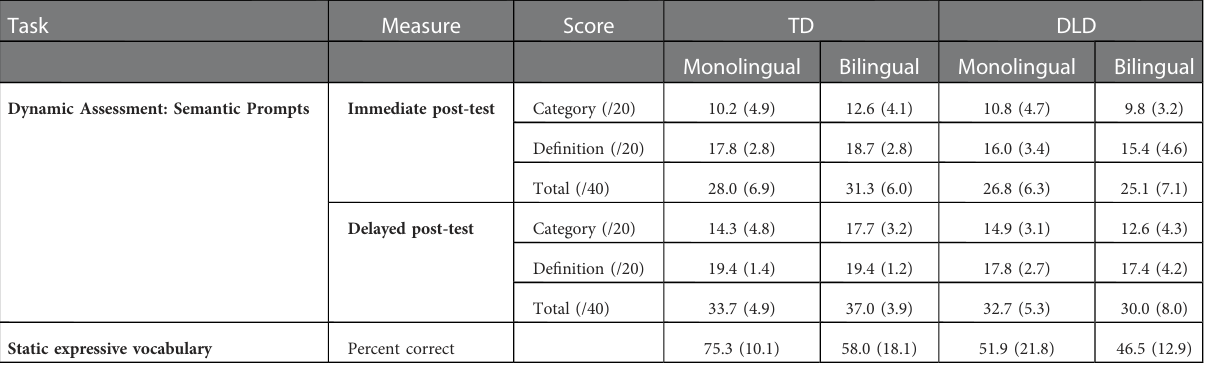
TABLE 7 Means (SDs) on expressive vocabulary and semantic